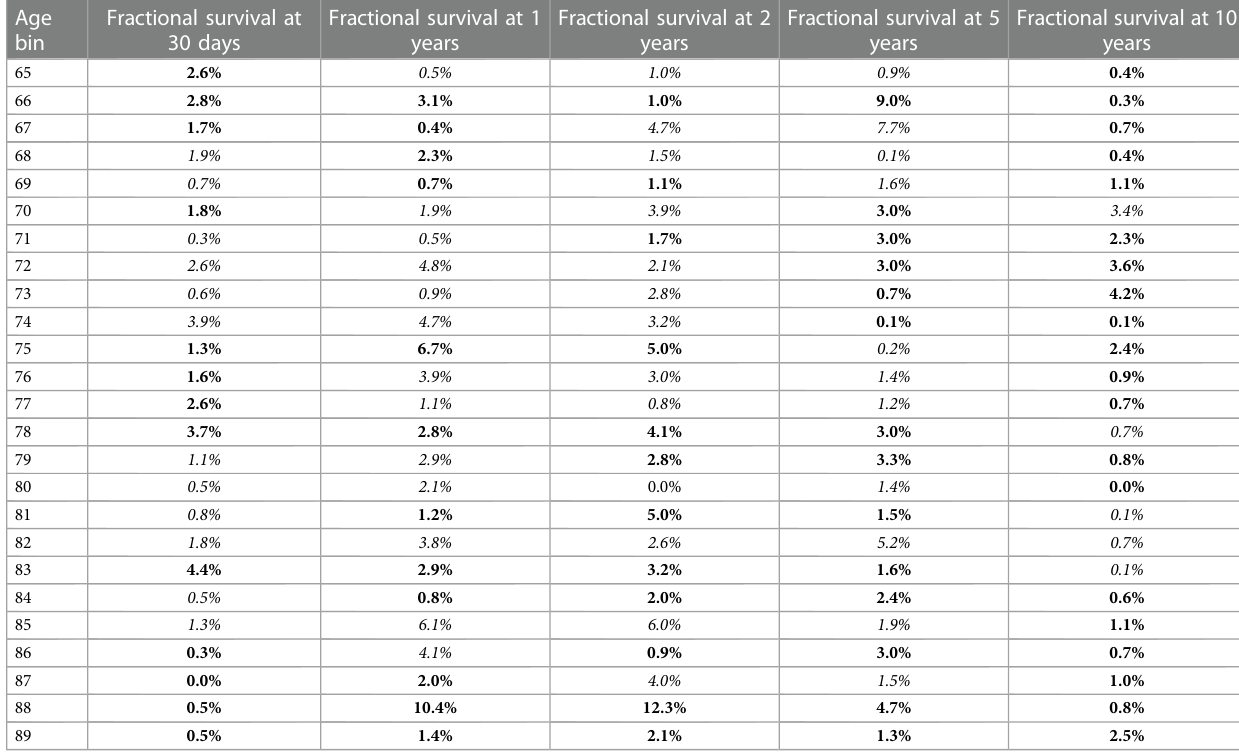
TABLE 5 Absolute differences in fraction survival rates at post-operative milestones, comparing TEST and RULE groups in all age bins a